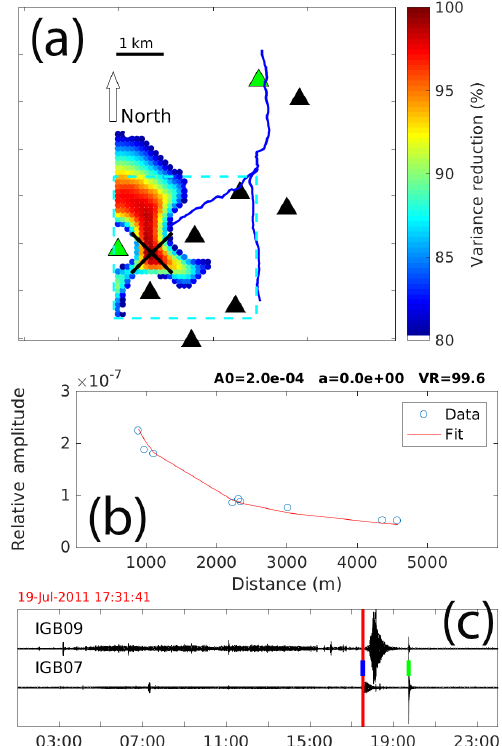
Figure 7. Decay-fit location of debris-flow front at the initiation of the event. (a) shows the seismic network, the torrent channel (blue line) and color-coded grid locations for variance reductions exceed- ing 80%. Black cross indicates best-fit location. The dashed cyan box outlines the region that defines detection in the upper catch- ment. (b) shows the amplitude attenuation fit associated with the best-fit location. (c) shows the time instance (red bar) on an Ill- graben catchment seismometer record (IGB07) and a Rhône Valley seismometer record (IGB09), both marked in (a) with green trian- gles (IGB07: southern station; IGB09: northern station). Small blue and green bars denote the beginning of debris-flow event and arrival of teleseismic signals from the M 6.2 2011 Fergana Valley earth- quake in